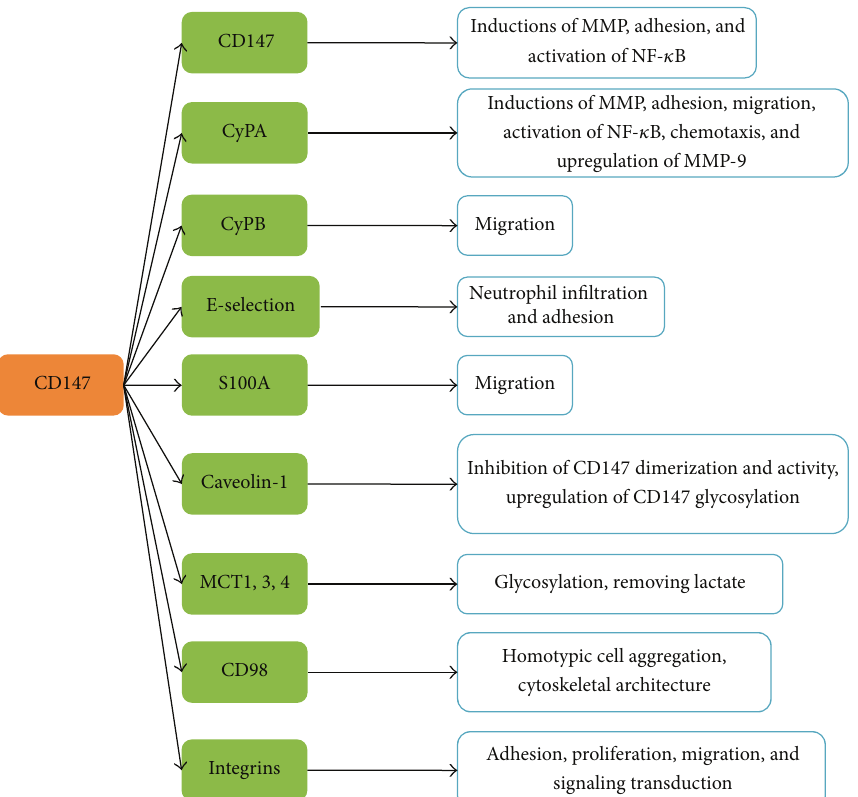
Figure 1: Illustration of CD147-interacting proteins and functions. MCT: monocarboxylate transporter; MMP: matrix metalloproteinase.